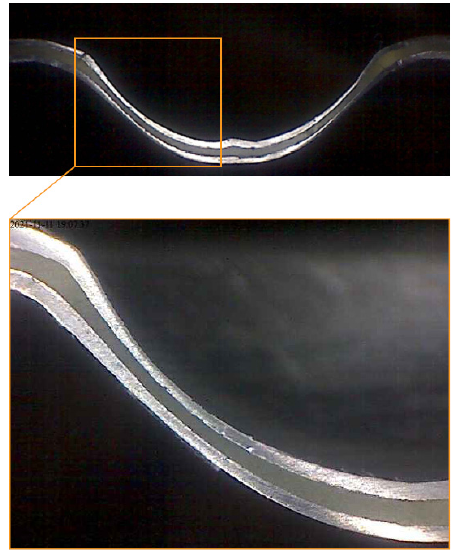
Figure 13. Cross-sections of the end of the stiffening rib.